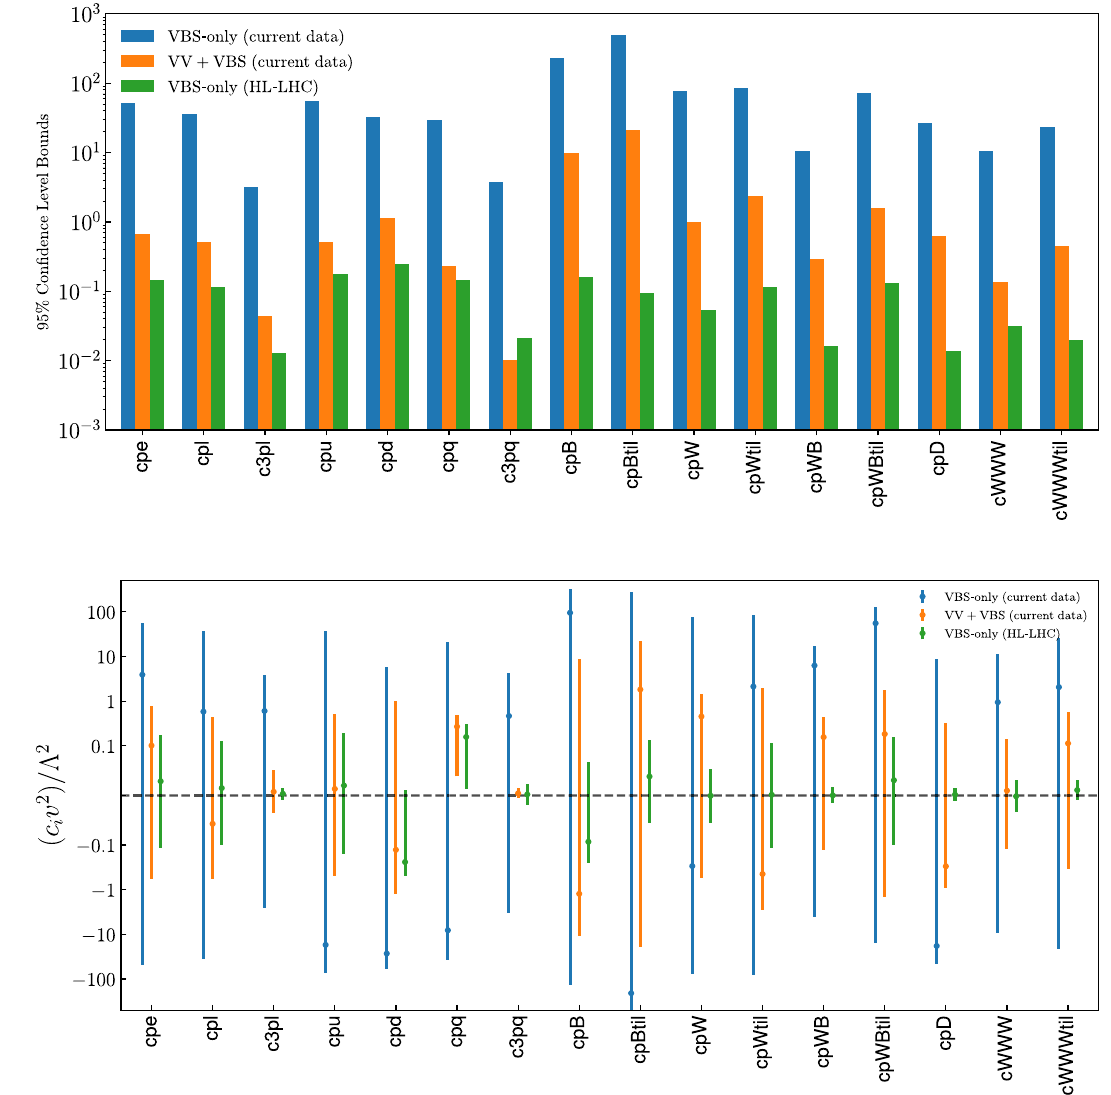
Fig. 28 Comparison of the 95% CL intervals for the EFT coefficients between three related analyses: the VBS-only and a the combined dibo- son+VBS fits based on current data, and the VBS-only fit based on the HL-LHC projections listed in Table